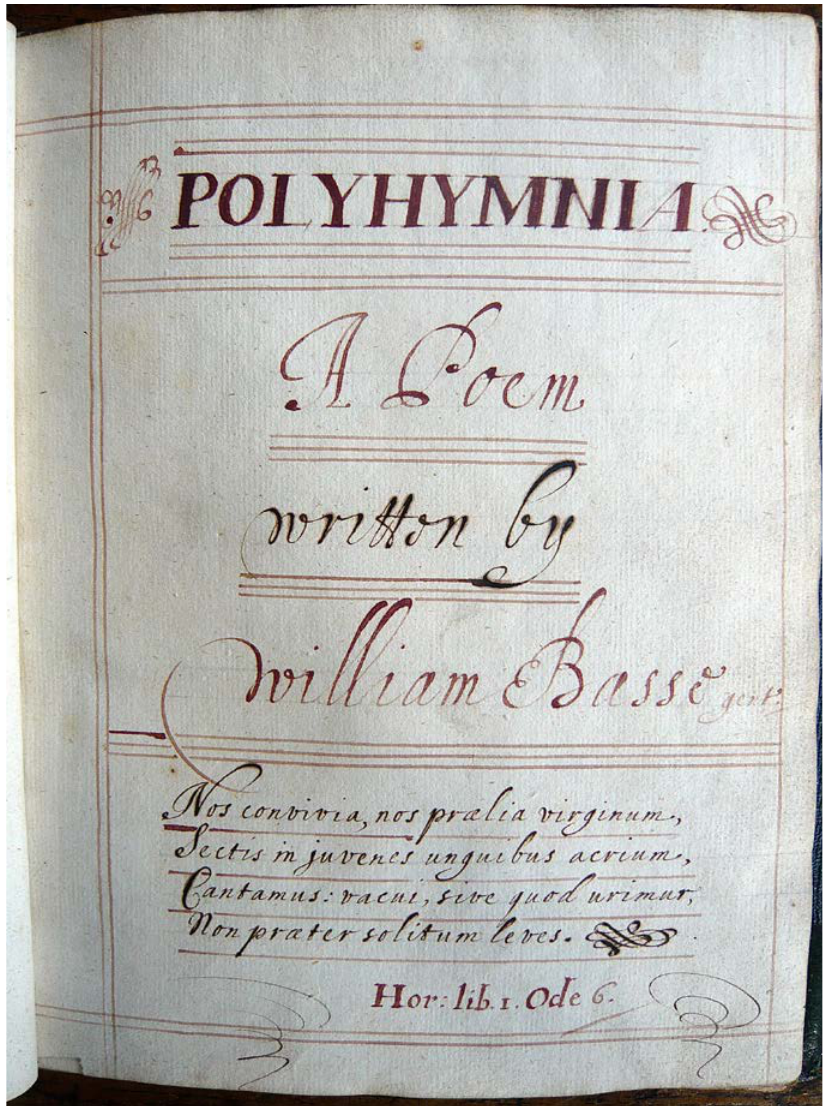
Fig. 1 - Title-page of William Basse’s Polyhymnia : Chetham’s Library, Manchester, MS Mun.A.3.54, f. 4r (all images reproduced by permission of Chetham’s